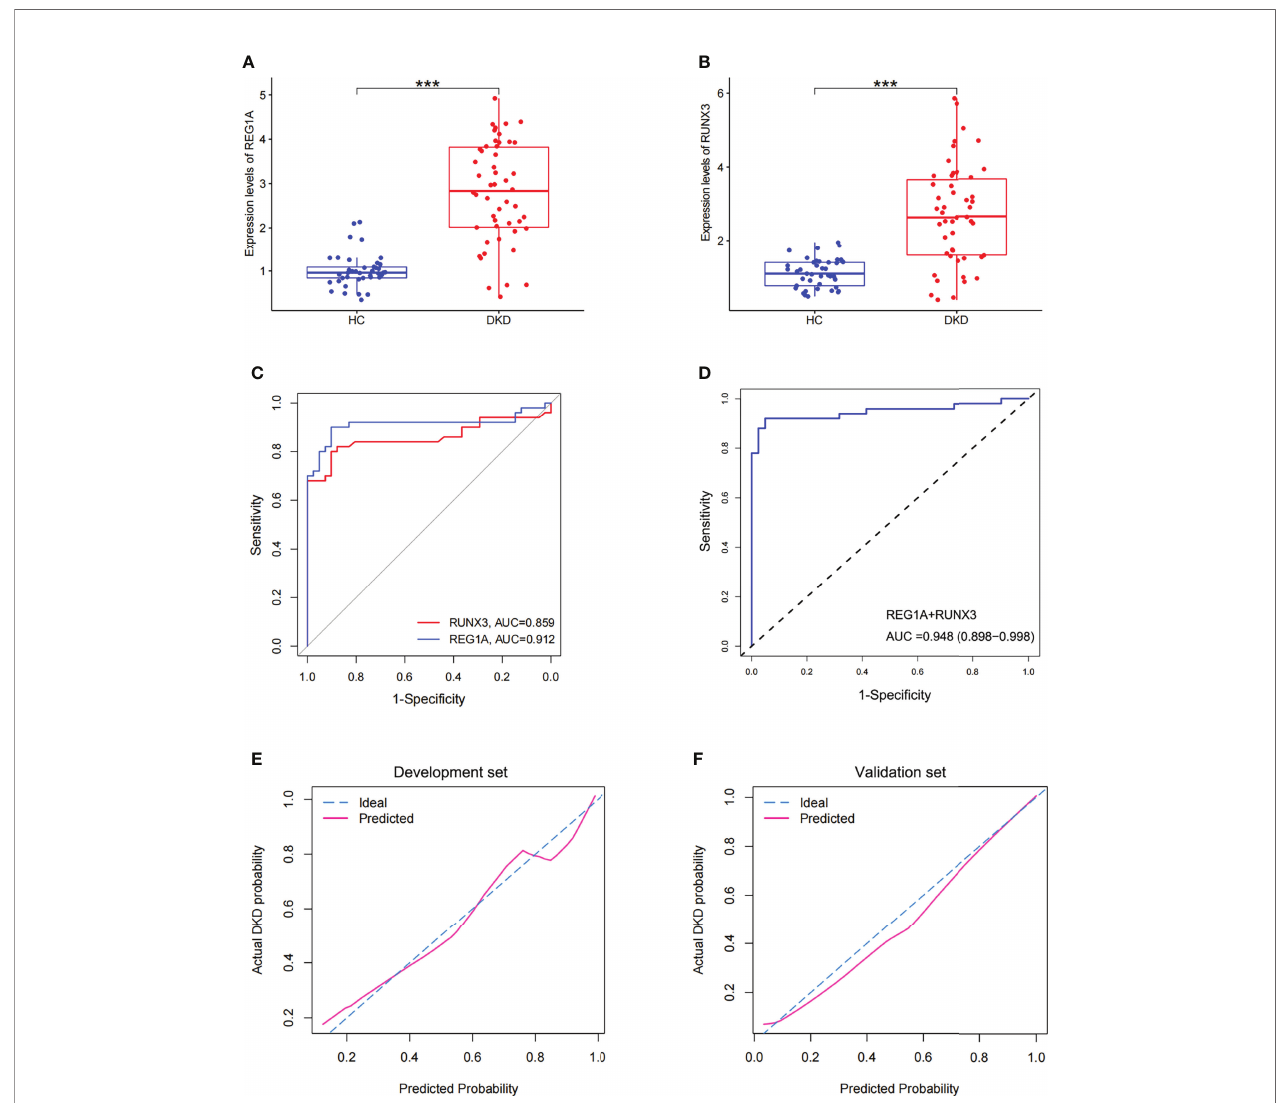
FIGURE 6 | Expression and diagnostic ef fi cacy of diagnostic markers in the validation cohort. (A, B) Box plots showed signi fi cantly higher expression levels of REG1A and RUNX3 (DKD vs. HC). (C) Separate ROC curves of REG1A and RUNX3 . (D) The ROC curve of the diagnostic ef fi cacy veri fi cation after fi tting two diagnostic markers to one variable. (E, F) Calibration curves of diagnostic markers. The diagonal dotted line represents a perfect prediction by an ideal model. The solid line represents the performance of the nomogram, of which a closer fi t to the diagonal dotted line represents a better prediction. The fi t of both the dashed and solid lines for the development set GSE142153 (E) and the validation set (F) was excellent. ***P